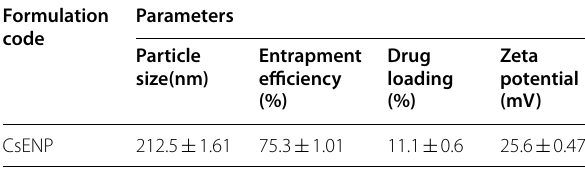
The values represent mean Table 2 Effect of change in SnCl efficiency of Nanoparticles with 99m Tc